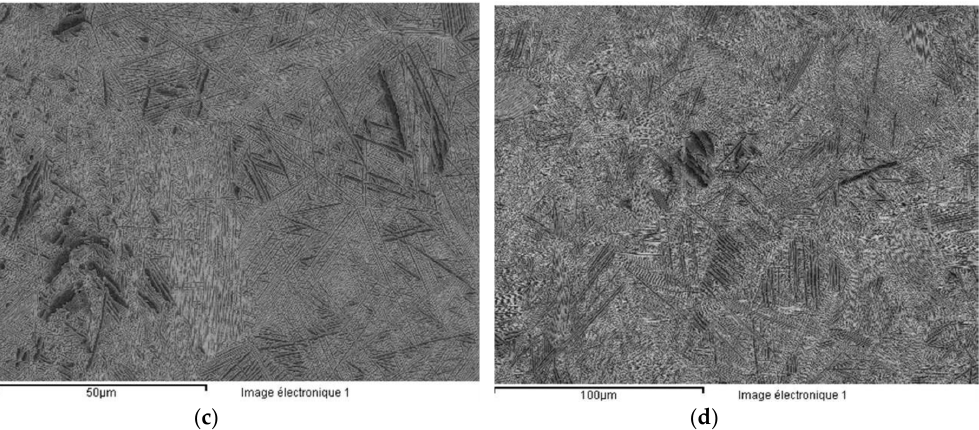
Figure 9. Ti13Nb13Zr alloy microstructure: longitudinal section ( a ) OM and ( b ) SEM images; transversal section ( c ) OM and ( d ) SEM images.